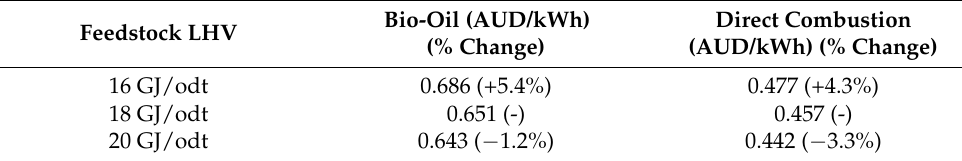
Table 6. Sensitivity analysis of the LCOE due to the calorific content of the raw biomass feedstock. For comparison, the LCOE of the modelled diesel system was AUD 0.582/kWh. Bio-Oil (AUD/kWh) Direct Combustion Feedstock LHV (% Change) (AUD/kWh) (% Change) 16 GJ/odt 0.686